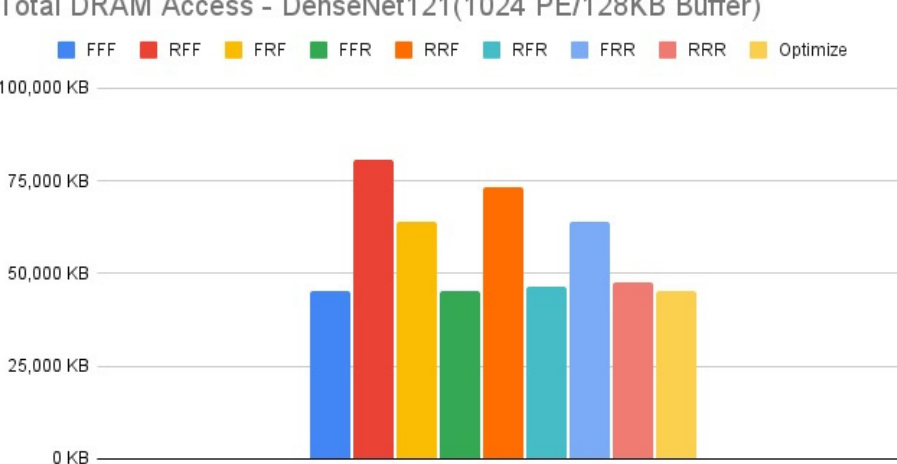
Figure 18. Total DRAM access—DenseNet121 (1024 PE/128 KB Buffer).